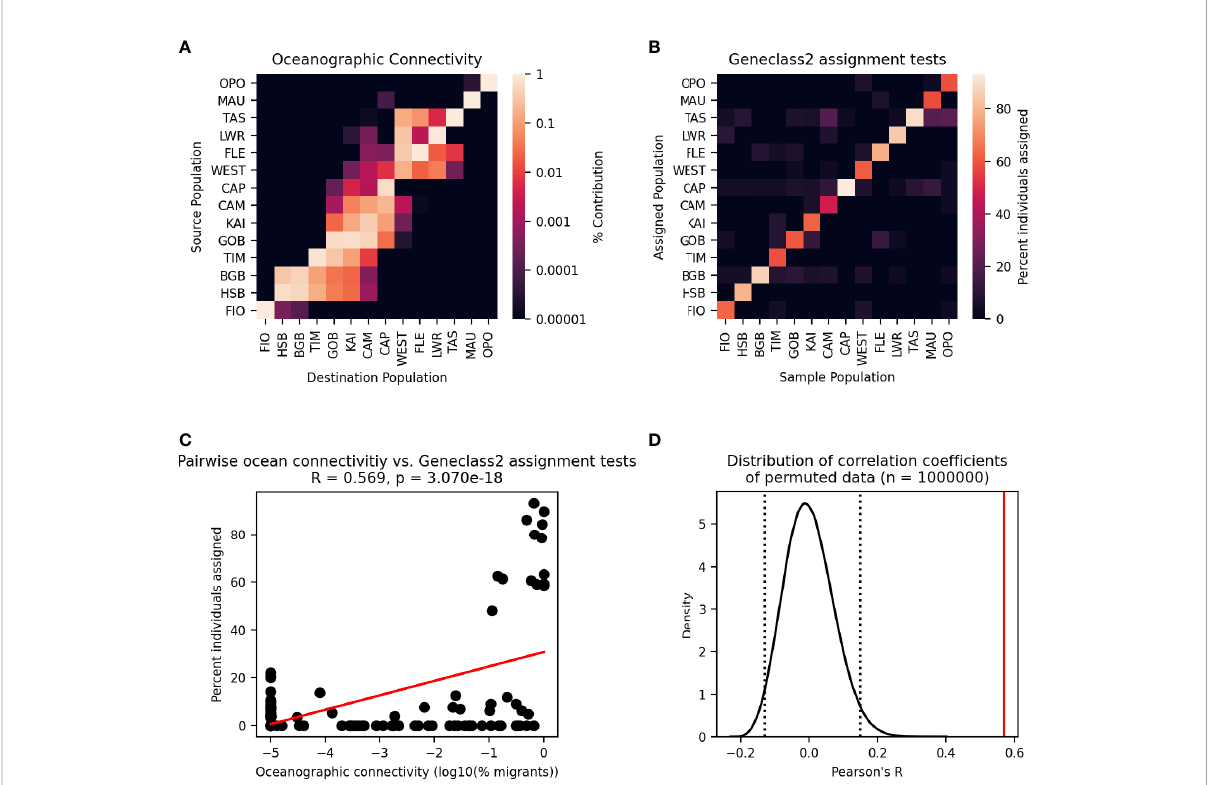
FIGURE 10 Modi fi ed Mantel test between migration matrix generated by Lagrangian particle tracking model and assignment tests performed in Geneclass2. (A) Particle tracking migration matrix. (B) Matrix of assignment tests of individuals. (C) Pairwise relationships between cells in the two matrices are plotted as points with a line showing the best fi t of the data. Pearson ’ s correlation coef fi cient and p-value of the correlation are given. (D) Distribution of correlation coef fi cients between the migration matrix and 1,000,000 permutations of the assignment testing data. Dotted lines enclose 95% of the distribution, and the solid line shows the correlation coef fi cient of the unpermuted